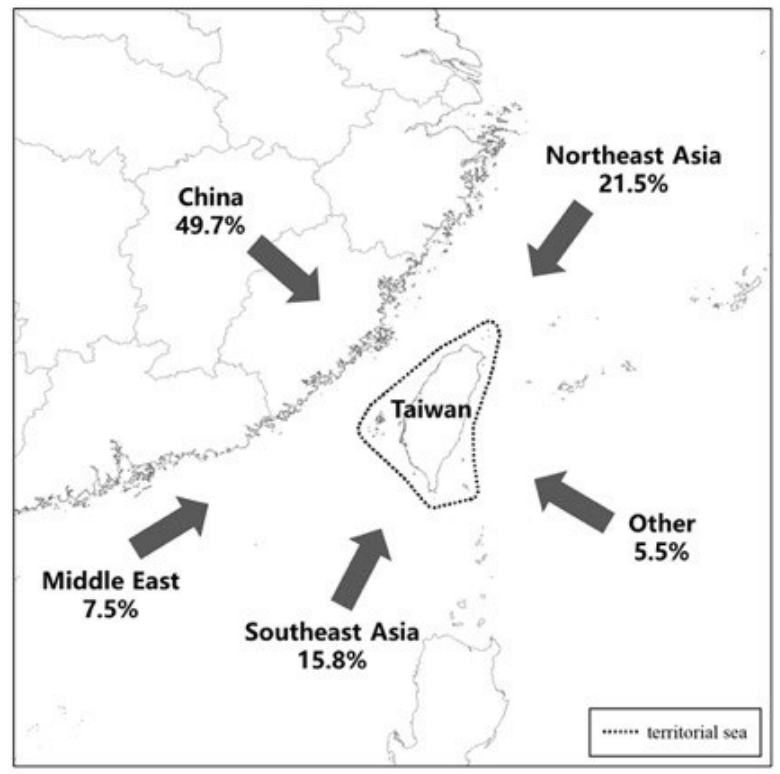
Figure 2. The percentage of the last port of calls originated for ships coming into Mailiao Harbor.